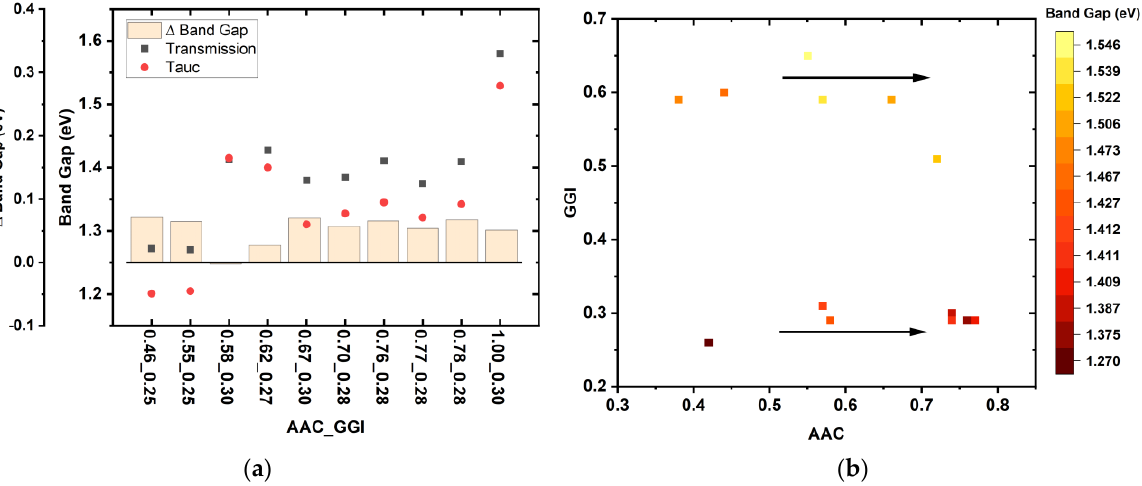
Figure 2. ( a ) Band gap of ACIGSe with various compositions obtained by linear fitting of the steep rise in transmission curves, or a Tauc plot of ( α h ν )² vs. (h ν ) along with the difference between the values; ( b ) Band gap values as a function of AAC and GGI ratios derived from slope fitting of transmission curves (arrows indicating increasing trend).